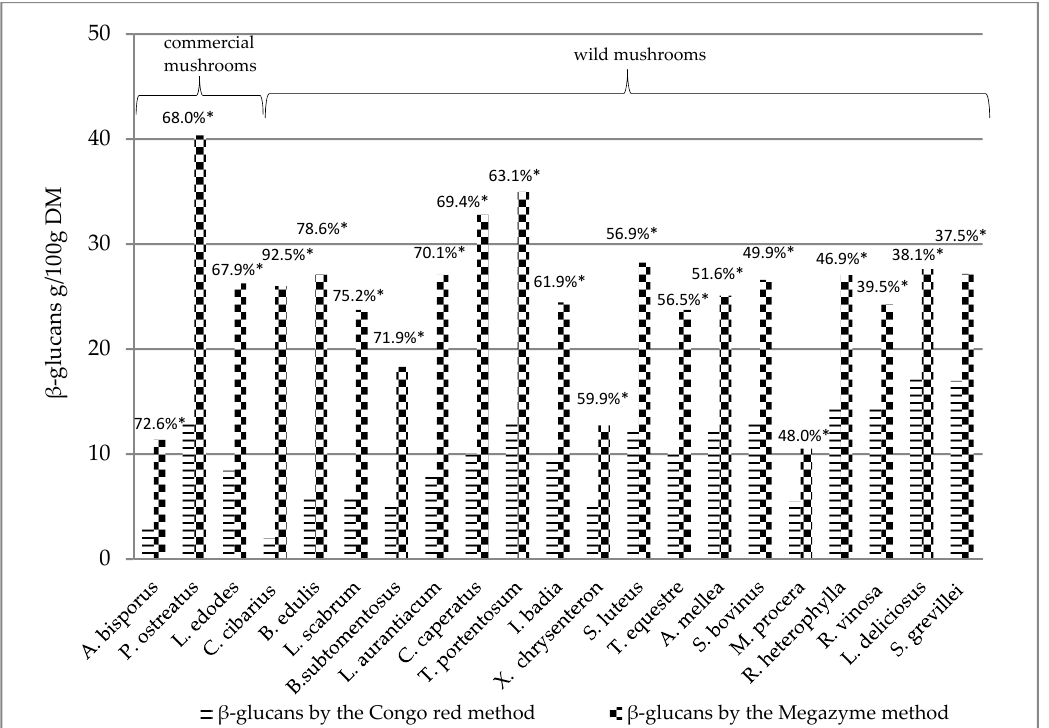
Figure 2 . Comparison of β -glucan contents assayed with the Congo red method and with the Megazyme method, expressed as the percentage difference. * Percentage difference between beta-glucans assayed by the Congo red method in relation to beta-glucans assayed by the Megazyme method, given in order of decreasing value of percentage difference.